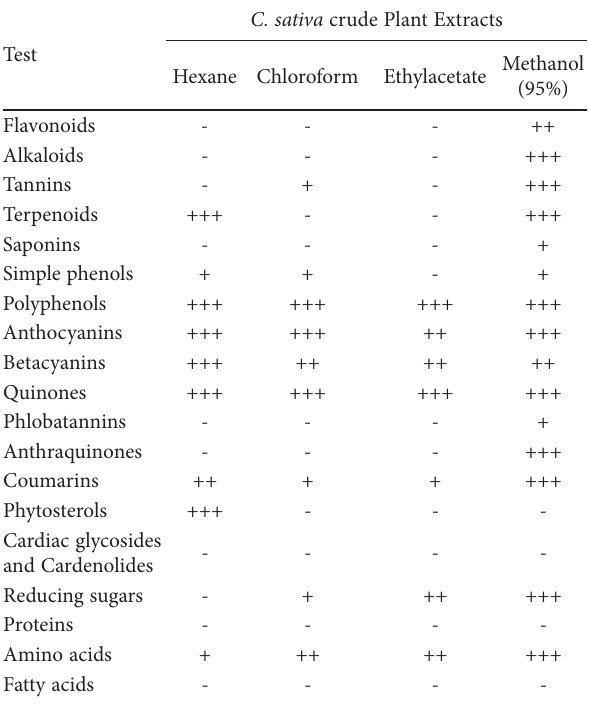
Table 2. Phytochemical screening test results for solvents extracts of wild C.